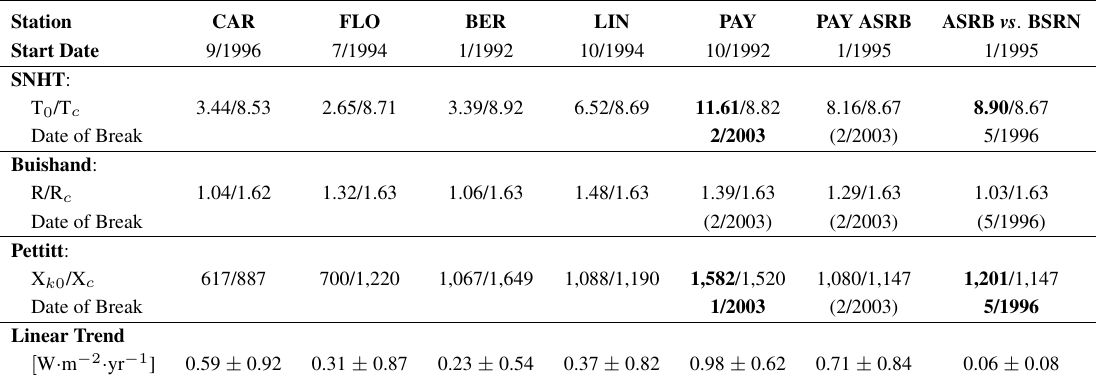
Results of absolute homogeneity testing of BSRN station